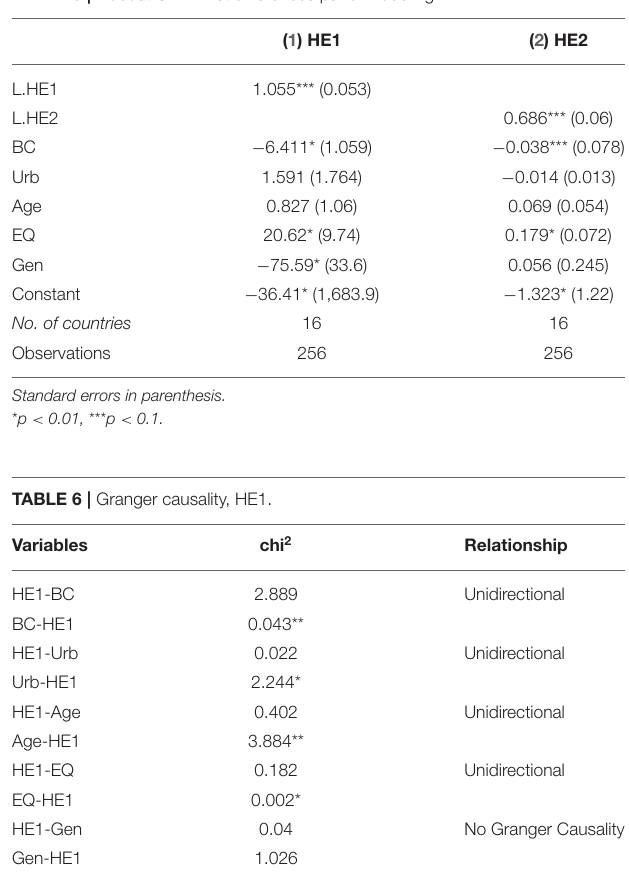
TABLE 7 | Granger causality,